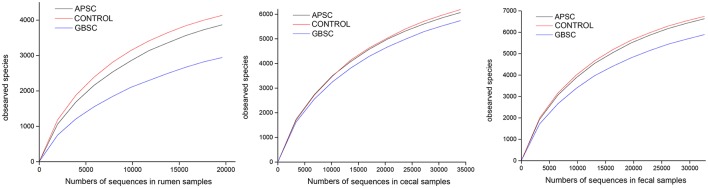
Rarefaction curves indicating the observed number of operational taxonomic units (OTUs) at a genetic distance of 3% in rumen bacterial communities of dairy cows under control feeding, an alfalfa-pellet SARA challenge (APSC) or a grain-based SARA challenge (GBSC) conditions. The number V1–V3 sequences of 16S rRNA gene in the pyrosequencing library was the pooled reads across individual samples (6 samples).